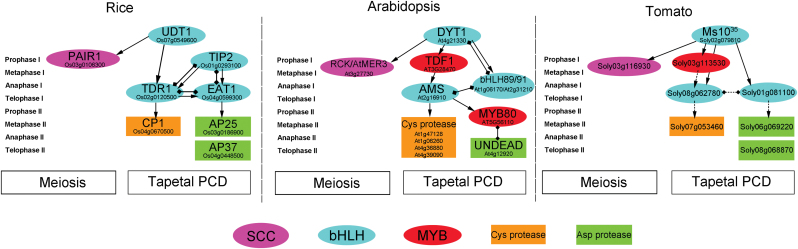
Comparative models for Ms1035 and its homologues in Arabidopsis and rice that regulate tapetal PCD and meiosis. Arrows represent positive regulation confirmed by RT-PCR or transcriptome analysis. Rhombuses depict protein–protein interaction or protein–promoter interaction confirmed by yeast two-hybrid, quantitative chromatin precipitation-PCR, or electrophoretic mobility shift assay. Dashed lines represent predicted regulation or interaction. The Arabidopsis and rice models are based on data reported by Jung et al. (2005), Li et al. (2006), Zhang et al. (2006), Wilson and Zhang (2009), Xu et al. (2010), Phan et al. (2011), Niu et al. (2013), and Fu et al. (2014). SCC, sister chromatid cohesion (synaptonemal complexes); bHLH, basic helix–loop–helix transcription factor; MYB, MYB transcription factor; Cys protease, cysteine protease; Asp protease, aspartic proteinase. (This figure is available in colour at JXB online.)